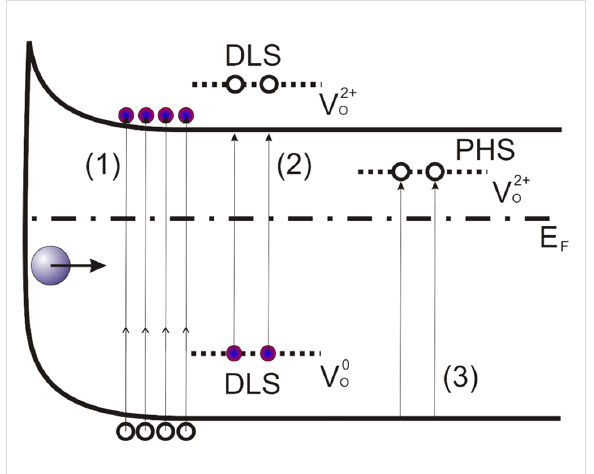
Figure 6: Schematic energy-level diagram of ZnO taking into account the existence of theoretically predicted [42] α - and β -type configura- tions of oxygen vacancies. The processes of electron–hole pair gener- ation via band-to-band absorption, charge carrier photoexcitation from a defect localized state (DLS) and to a perturbed host state (PHS) of an oxygen vacancy are marked as (1), (2) and (3), respectively.